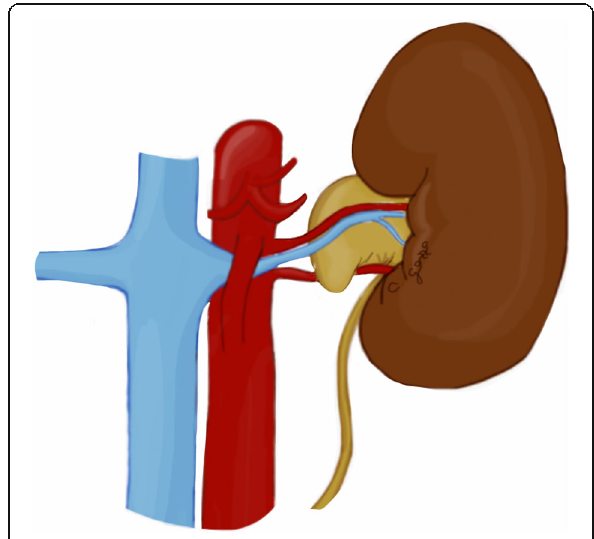
Fig. 12 Drawing illustrating the coronal view of ureteropelvic junction obstruction